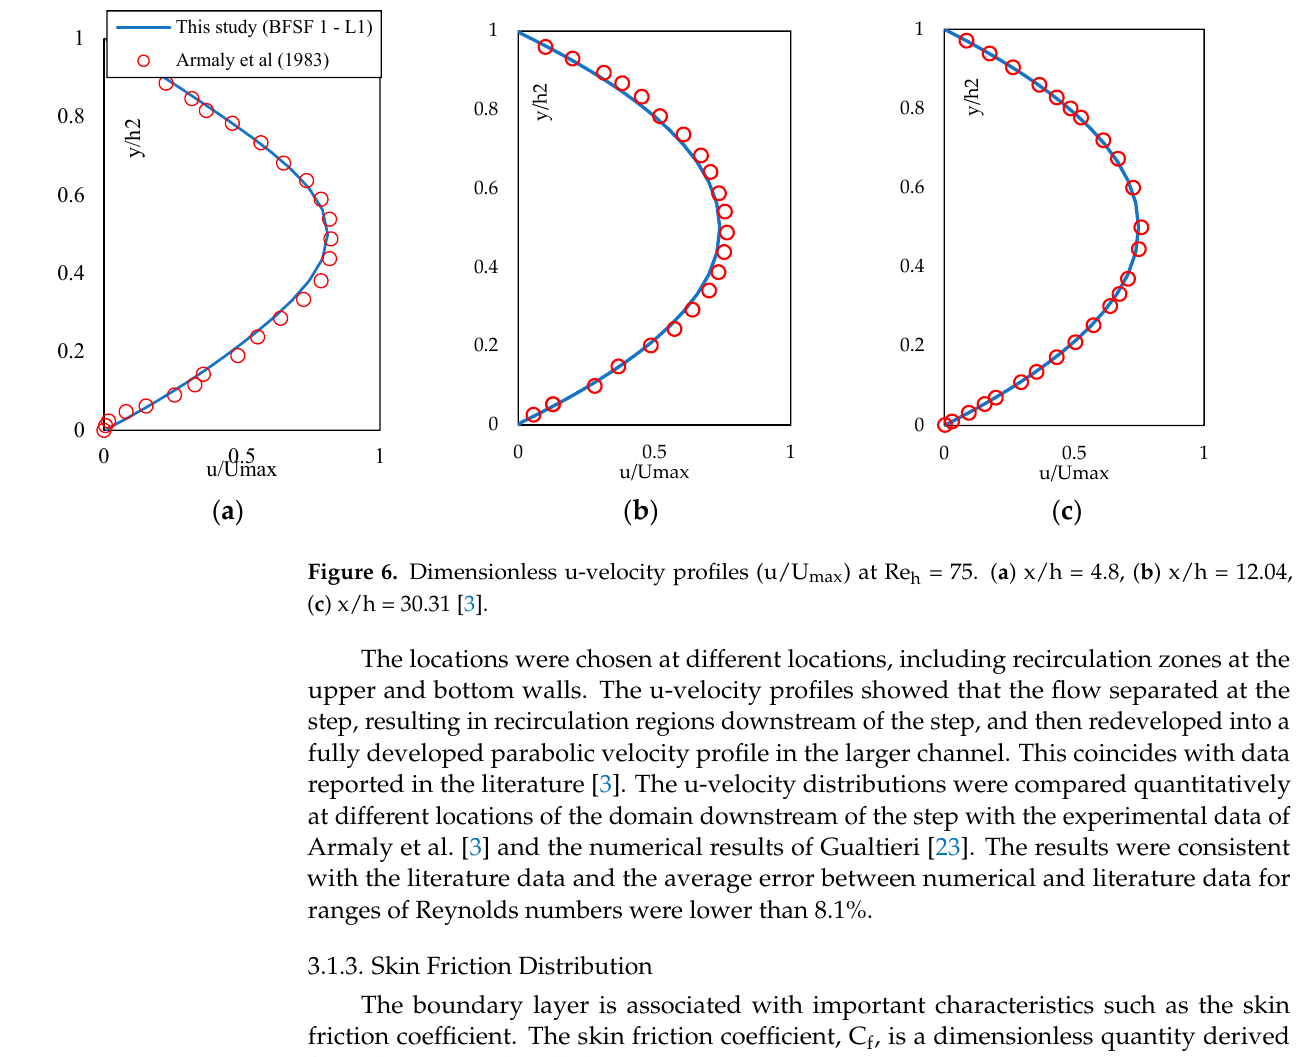
Figure 7. Dimensionless u-velocity profiles (u/U max ) at Re h = 672. ( a ) x/h = 5, ( b ) x/h = 7.5, ( c ) x/h = 12, ( d ) x/h = 15, ( e ) x/h = 22.5, ( f ) x/h = 30 [23]. The locations were chosen at different locations, including recirculation zones at the upper and bottom walls. The u-velocity profiles showed that the flow separated at the step, resulting in recirculation regions downstream of the step, and then redeveloped into a fully developed parabolic velocity profile in the larger channel. This coincides with data